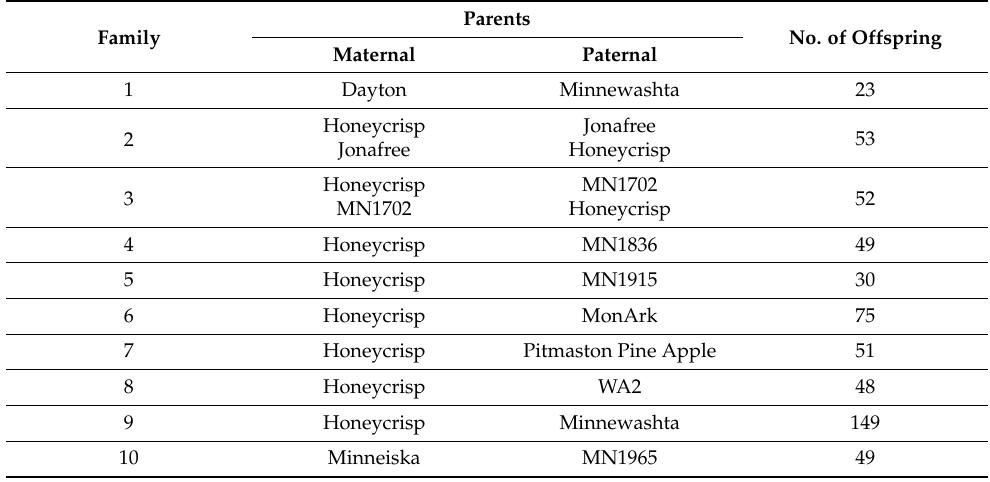
Table 1. Number of offspring in pedigree-connected full-sib families that represented 14 breeding parents. Family